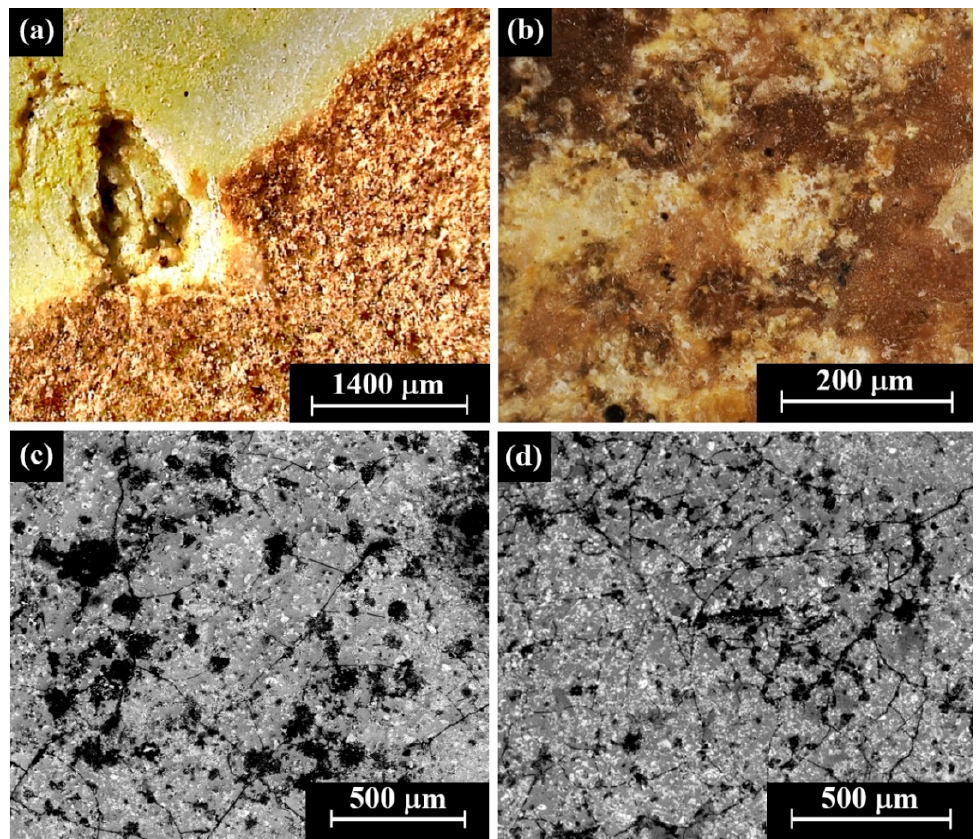
Figure 12. Microscopic images of brown pigment. Tile no. 334, Type A: ( a ) boundary between yellow and brown areas (multifocal LM); ( b ) large magnification of brown pigment area (multifocal LM); tile no. 319, Type A: ( c ) light brown pigment area (SEM, BSE mode); and ( d ) dark brown pigment area (BSE mode).